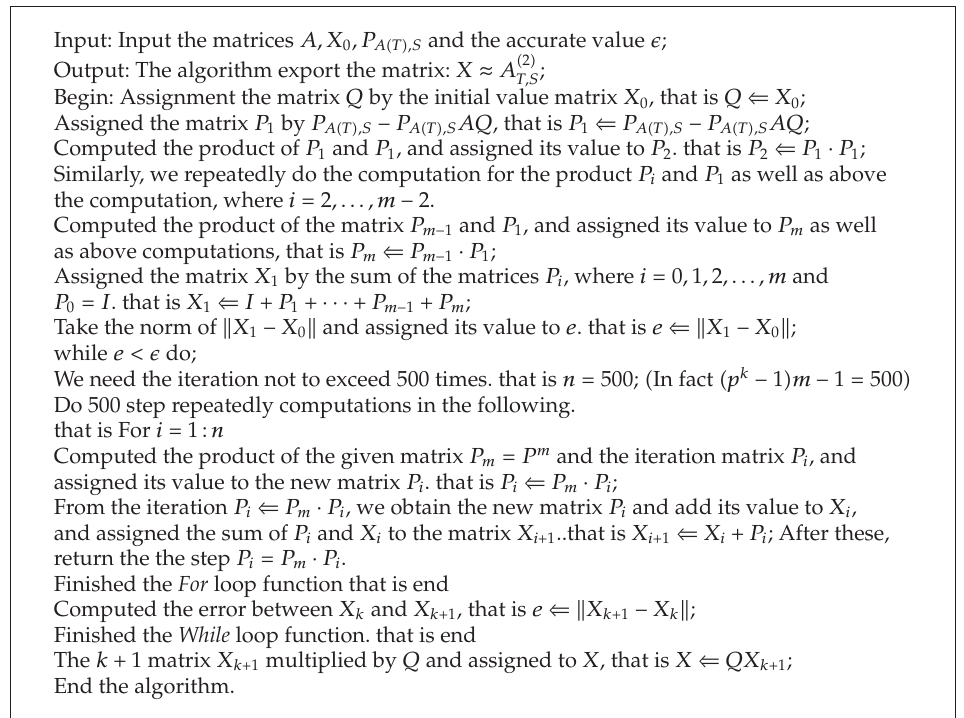
(cid:2) 2 (cid:3) T,S